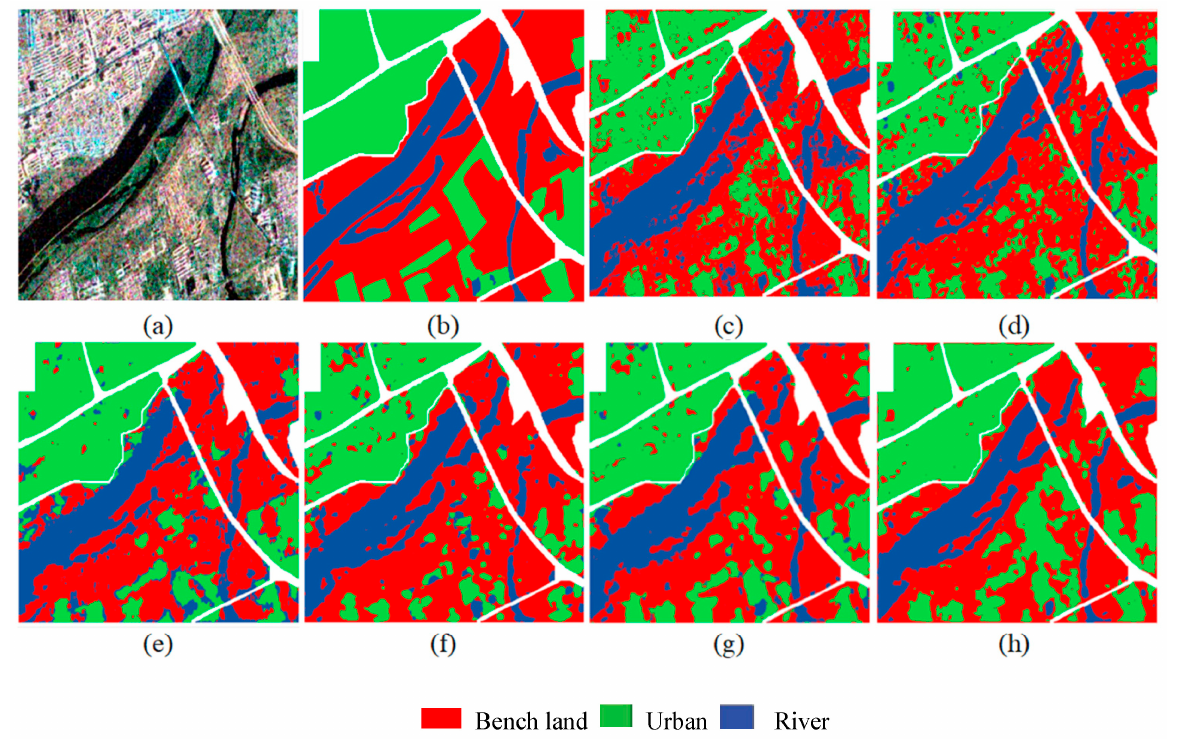
Figure 15. Classification results of the Xi’an dataset. ( a ) Pauli image. ( b ) Ground-truth image. ( c ) RN. ( d ) RN-SWANet. ( e ) RRN. ( f ) RRN-SWANet. ( g ) 3D-RRN. ( h ) 3D-ARRN. Table 6. The classification accuracy (%) of different methods with 7 labeled samples per class on Xi’an dataset.